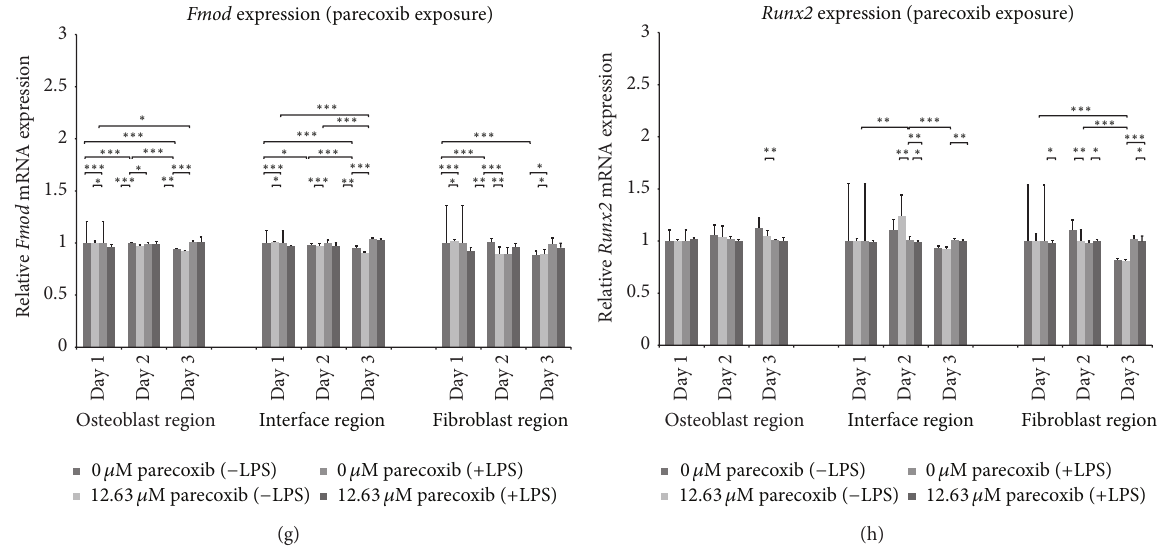
Figure4:(a)–(h)Effectsofibuprofenandparecoxibongeneexpressionattheosteoblast,interface,andfibroblastregionsduringbone-tendon integration in vitro . Alpl : alkaline phosphatase; Bglap : bone gamma-carboxyglutamate protein; Fmod : fibromodulin; LPS: lipopolysaccharide; Runx2 : runt-related transcription factor 2. 𝑃 values are provided as follows: ∗ 𝑃 < 0.05 , ∗∗ 𝑃 < 0.01 , and ∗∗∗ 𝑃 < 0.001 .